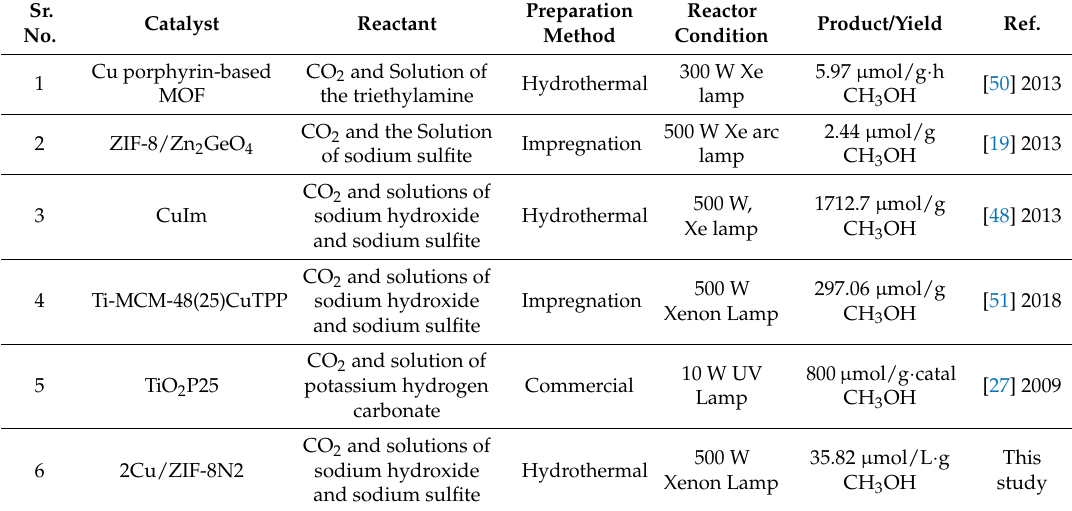
Table 1. Recent Progress in photocatalytically reduction of CO 2 .